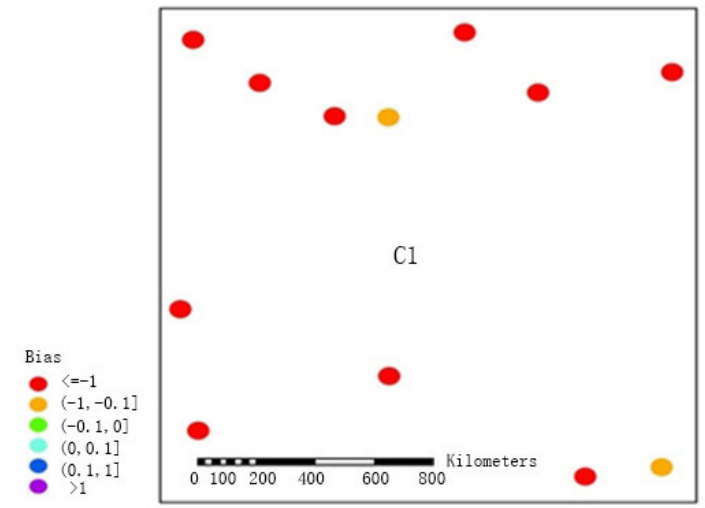
Figure 7. Spatial distribution map of biases in region C1 with FMS between May and September from 2005 to 2010.